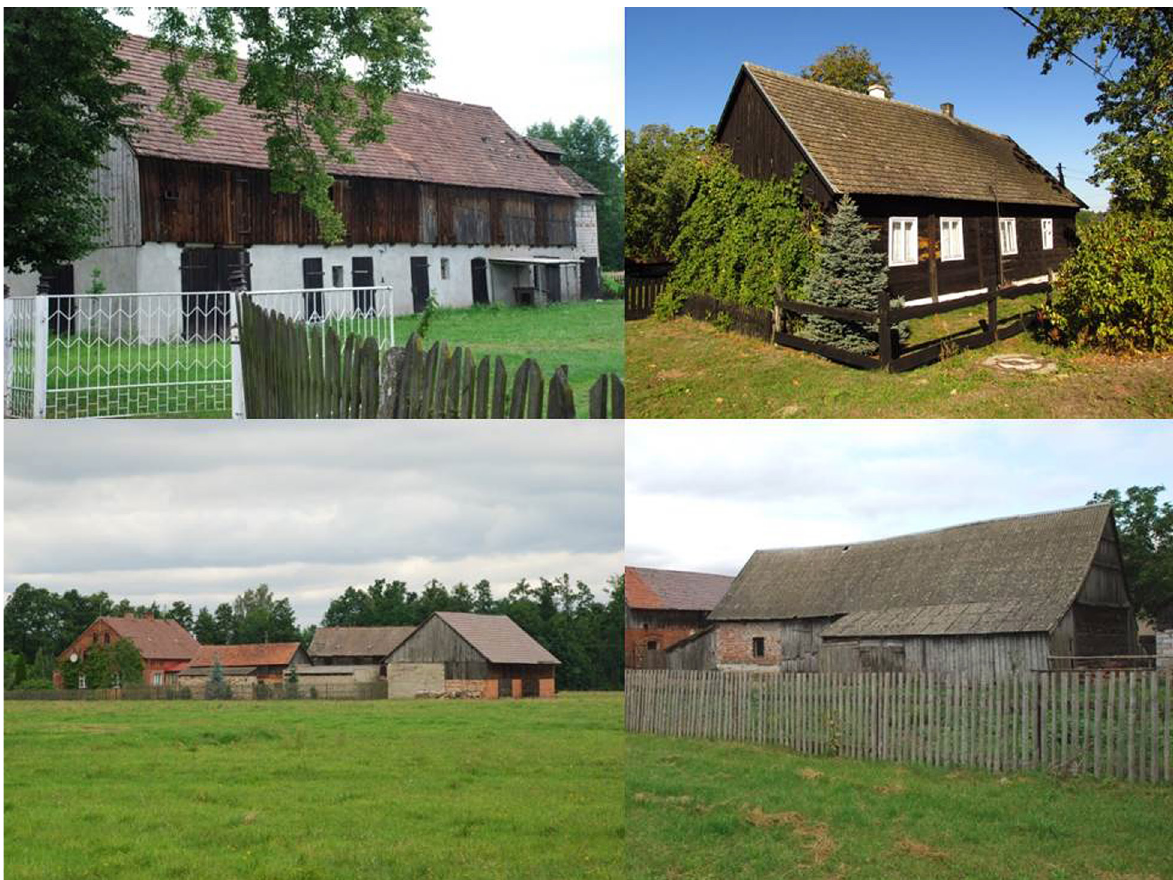
Fig. 4. Dutch law settlement in village